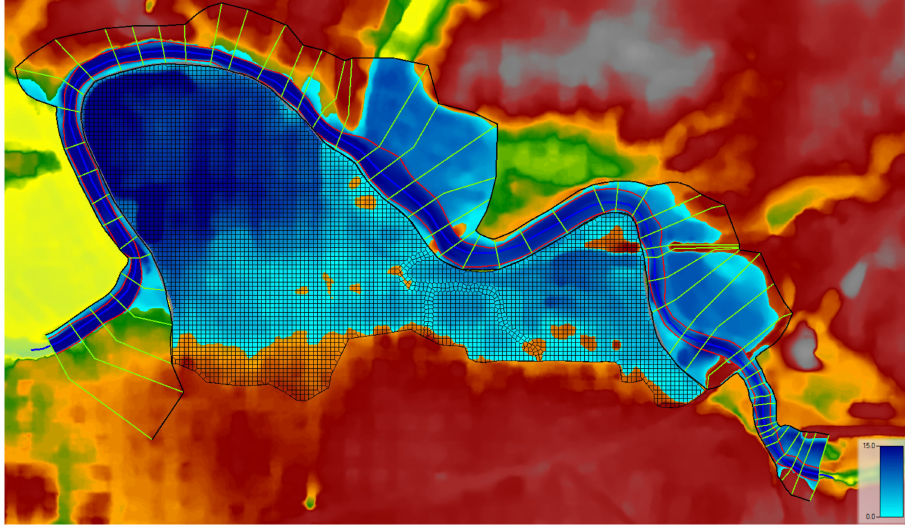
Figure 7. Inundation area (water depths shown in blue) at the City of Muncie without the O/S model.